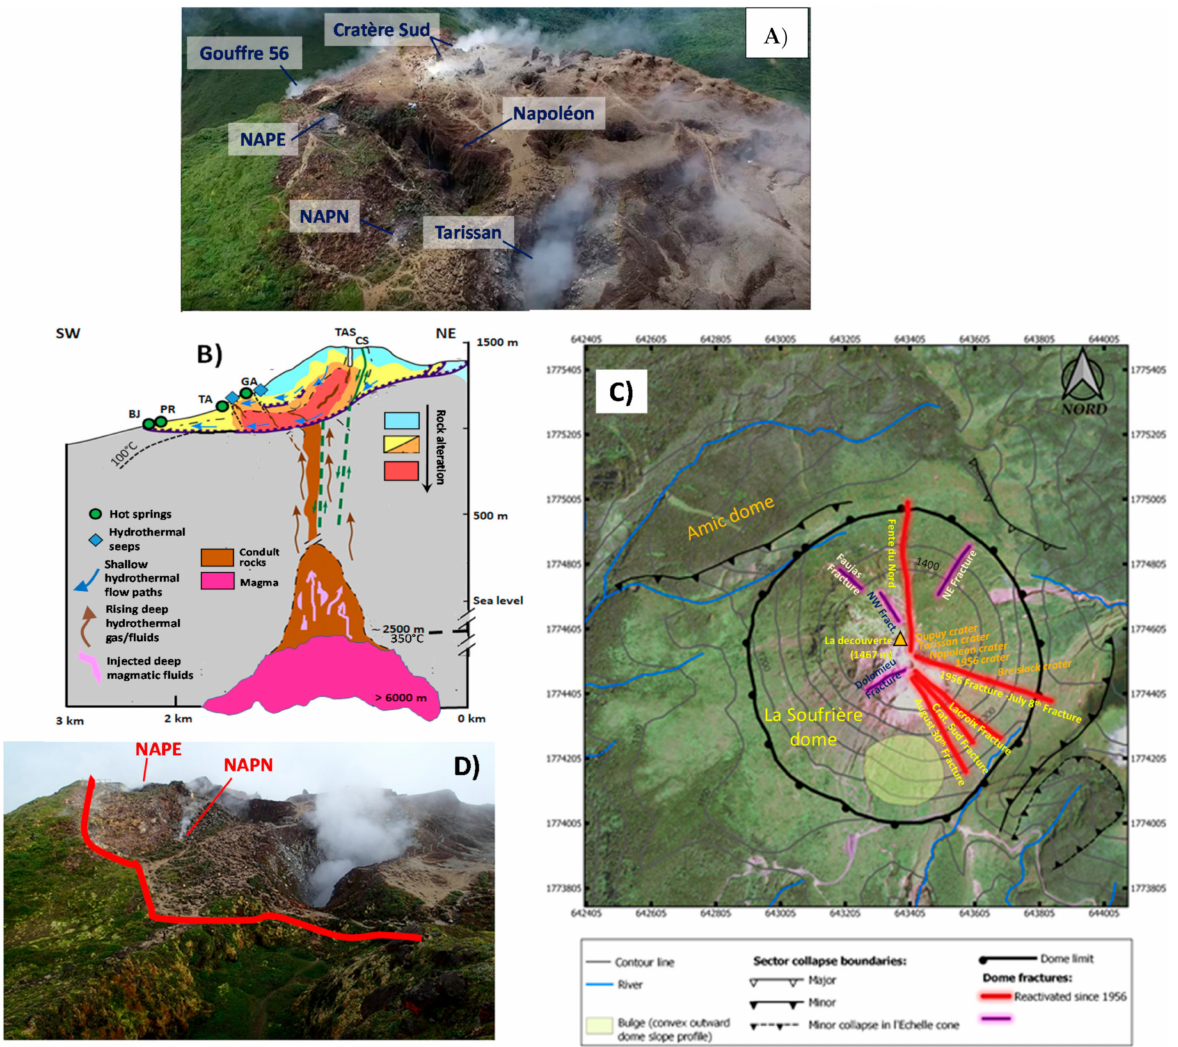
Figure 2. The Soufri è re–Grand D é couverte volcanic complex. ( A ) Drone view of La Soufri è re dome summit with indication of main emission centres (courtesy of the OVSG-IPGP). ( B ) NE-SW geological profile of the main rock alteration profile and shallow plumbing system (modified from Rosas-Carbajal, 2016 [10]). ( C ) Simplified geological mapof La Soufri è re dome and its surroundings (based on Microsoft ® Bing™ Maps and Brothelande et al. 2014 [11]). ( D ) View of La Soufri è re dome illustrating the expanding hot and degassing area and with the NAPN (2014) and NAPE (2016)